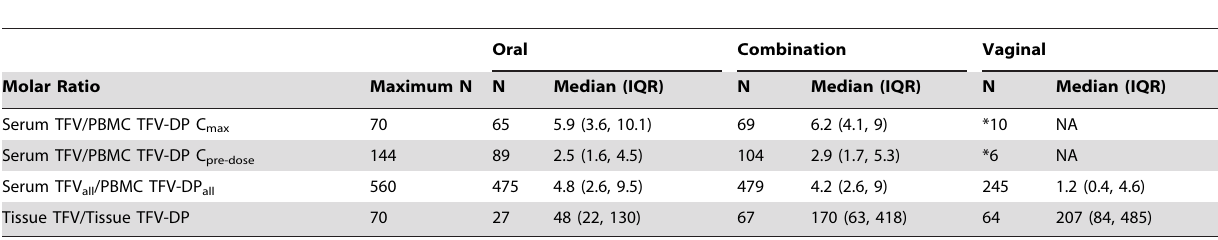
Table 5. Ratio of unphosphorylated TFV to phosphorylated TFV-DP by anatomic sampling sites.